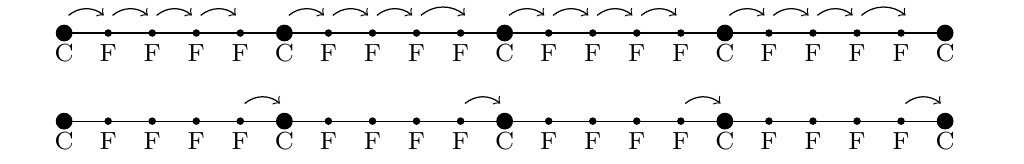
Fig. 3 Illustration of F-relax- ation (top) and C-relaxation